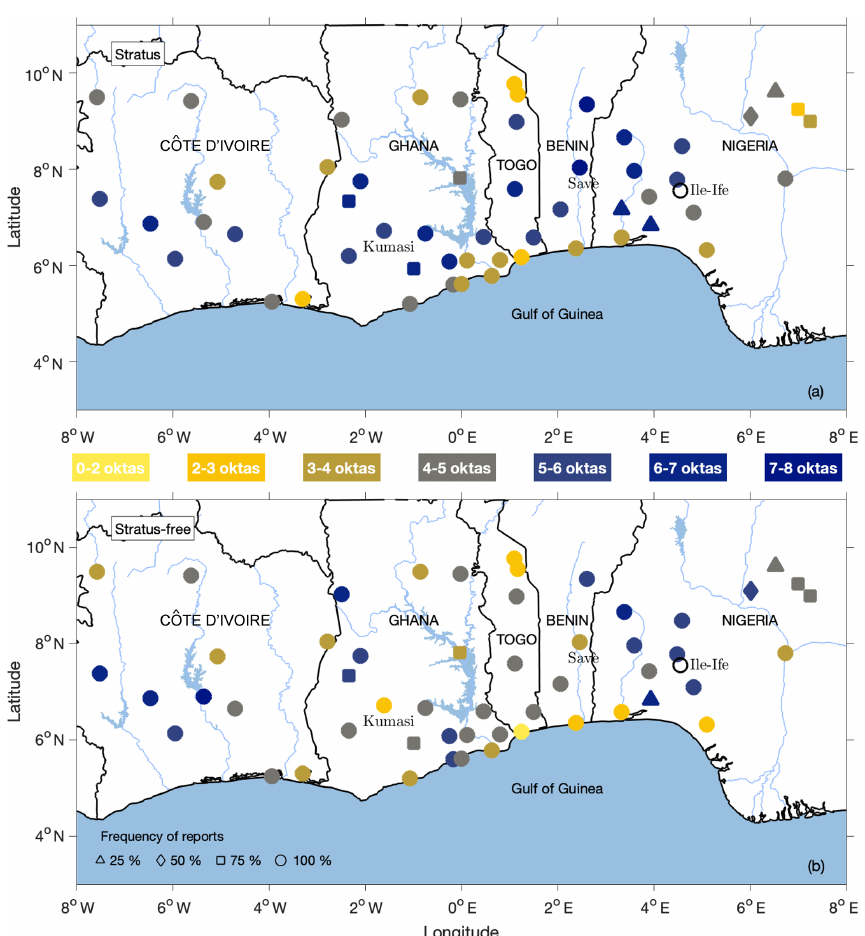
Figure 3. The mean low-level cloud coverage (color) reported at synoptic weather stations across SWA at 06:00UTC for stratus (a) and stratus-free (b) nights. Different marker types indicate how often the reports were available at a particular